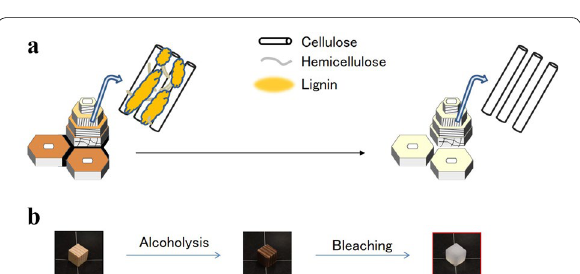
Fig. 1 a Schematic representation of model illustrating the objective to wholly delignify from wood while maintaining the anatomical and cell wall structure as well as the microfibril orientation and cellulose crystalline structure. b Method used to develop colorless wood via two-step processing involving alcoholysis and bleaching